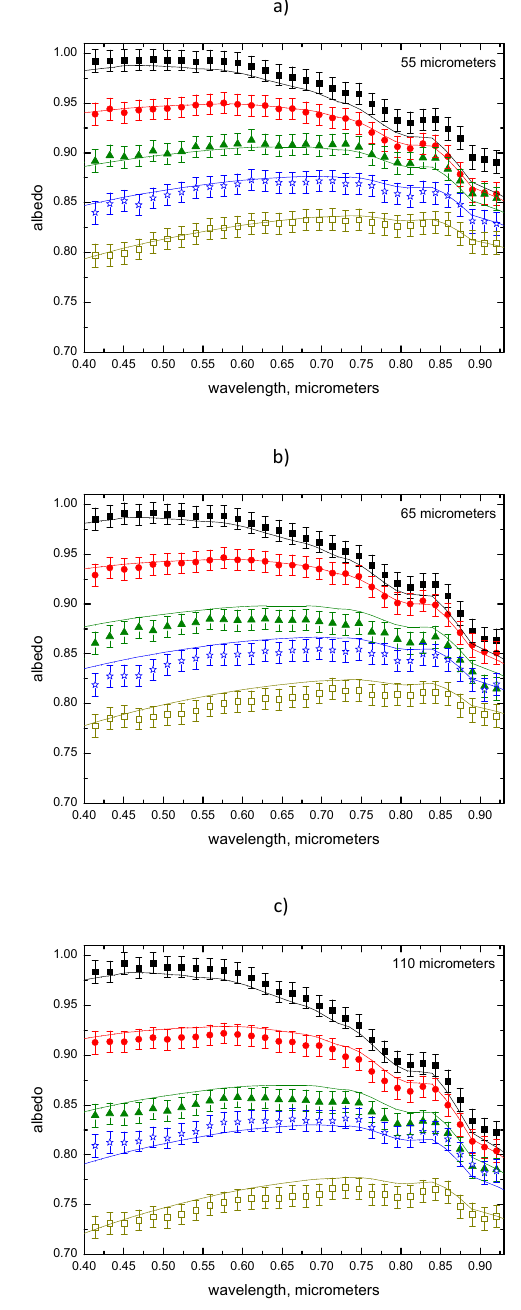
Fig. 1. The spectral dependence of snow plane albedo at the nadir illumination at various levels of snow pollution and effective radii – (a) 55, (b) 65, and (c) 110µm. The results of calculations at B i = 77 . 02 and B s = 22 . 15 are given by lines. The dependence of χ i (λ) was taken from Warren and Brandt (2008). Symbols repre- sent laboratory measurements performed by Hadley and Kirchstet- ter (2012) at concentrations 0, 0.1, 0.45, 0.86, and 1.68µgg − 1 (from top to bottom,